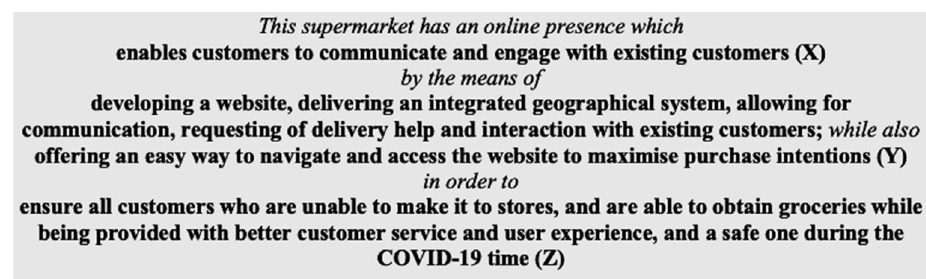
Figure 6. The root definition of the prototype supermarkets strategy.